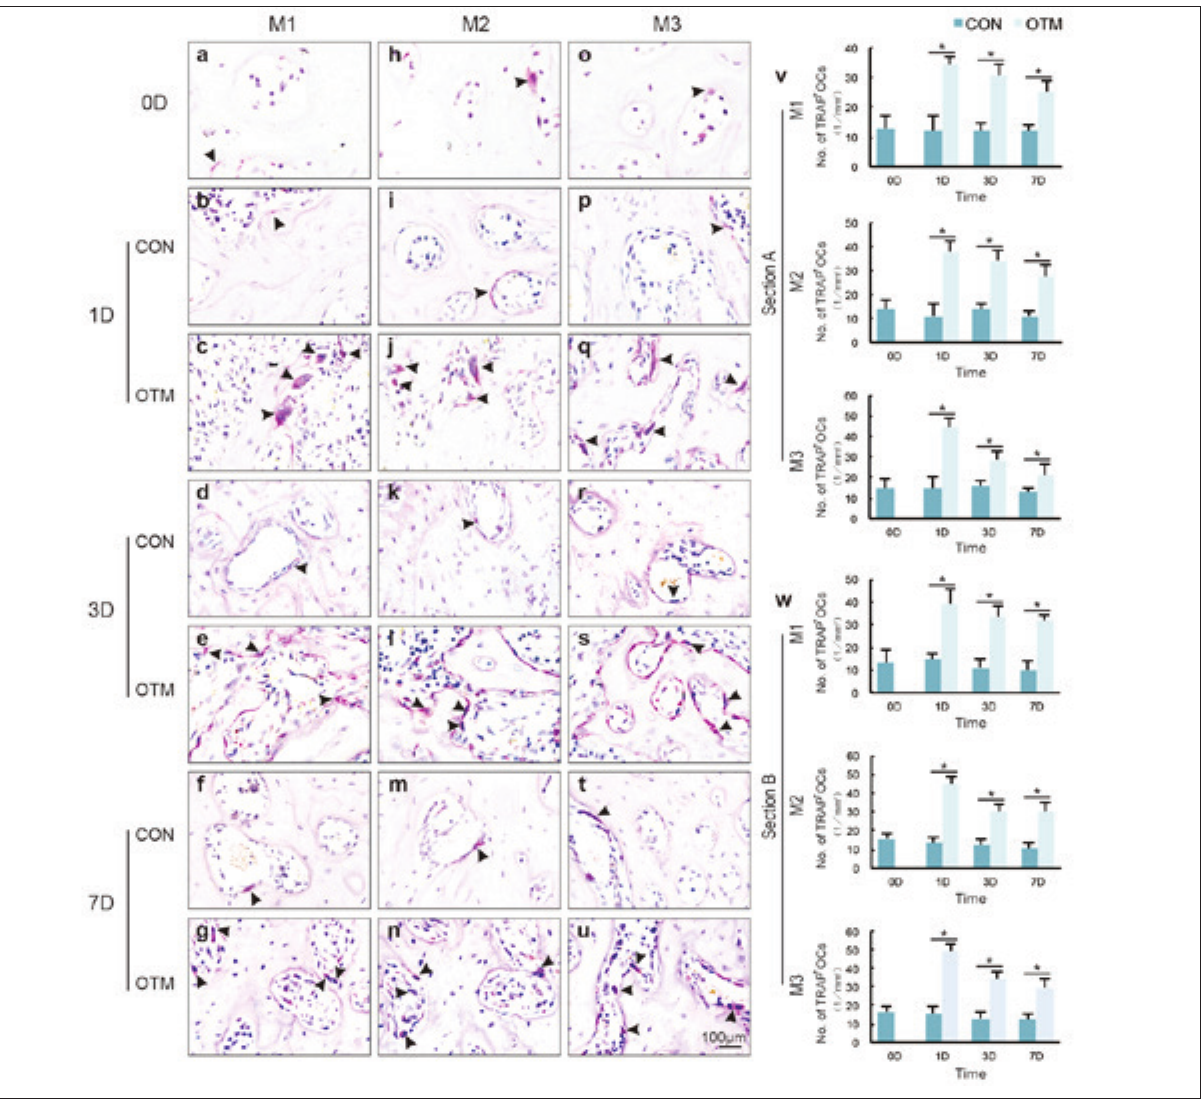
Figure 2. The local orthodontic force acting on M1 increased the bone resorption of the hemi-maxillary alveolar bone. TRAP staining of the maxillary alveolar bone. The number of osteoclasts (arrowhead, TRAP-positive cells) was increased in all of M1, M2 and M3 zones at section A and B level. (* p < 0.05, N =